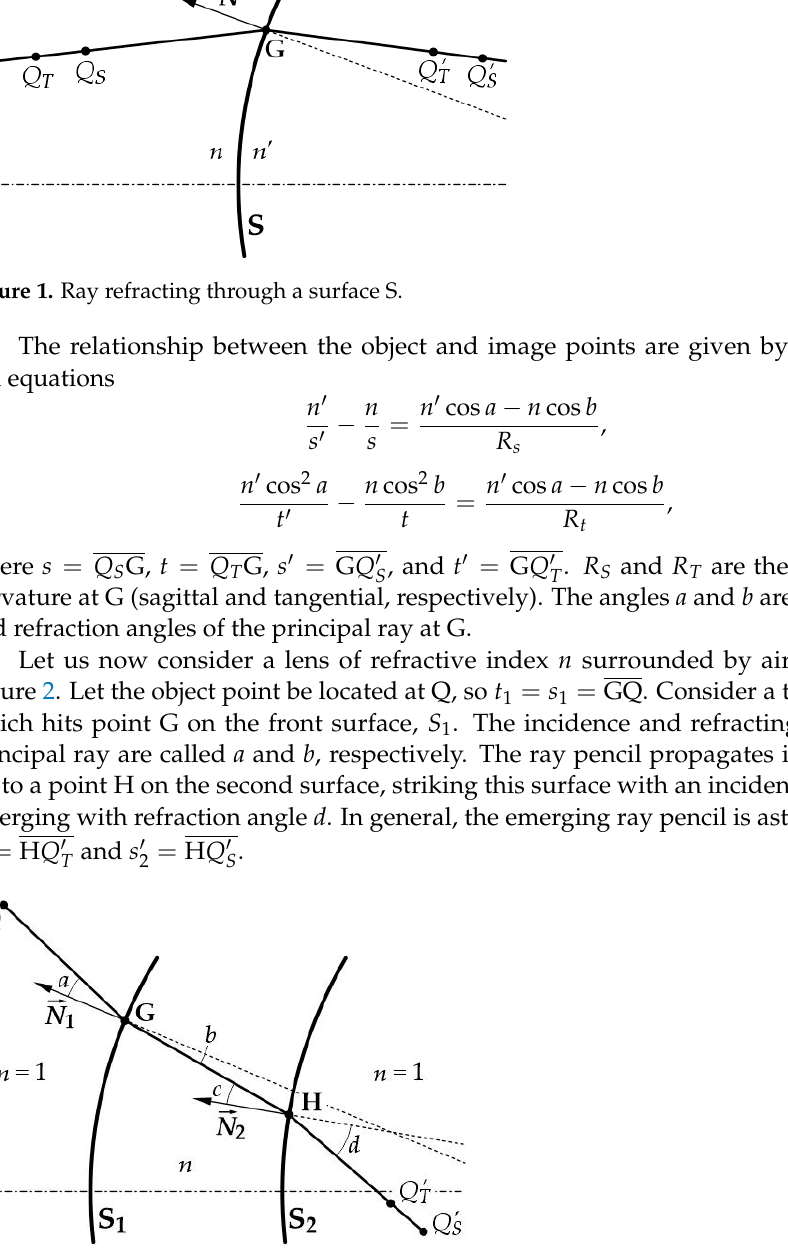
Figure 2. Ray propagation through a lens.